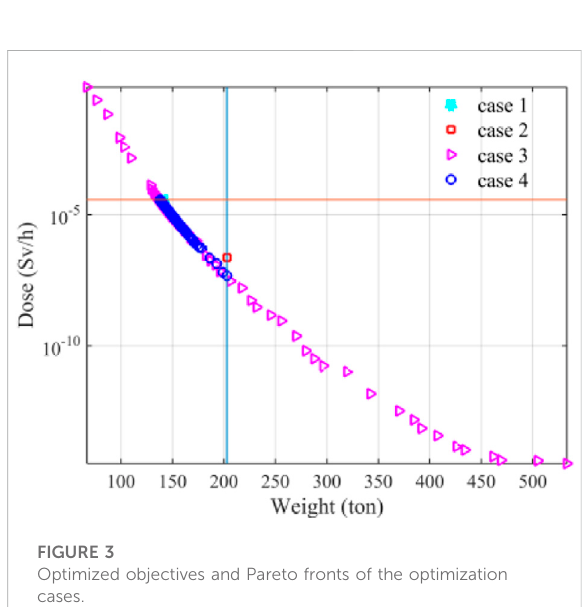
FIGURE 3 Optimized objectives and Pareto fronts of the optimization